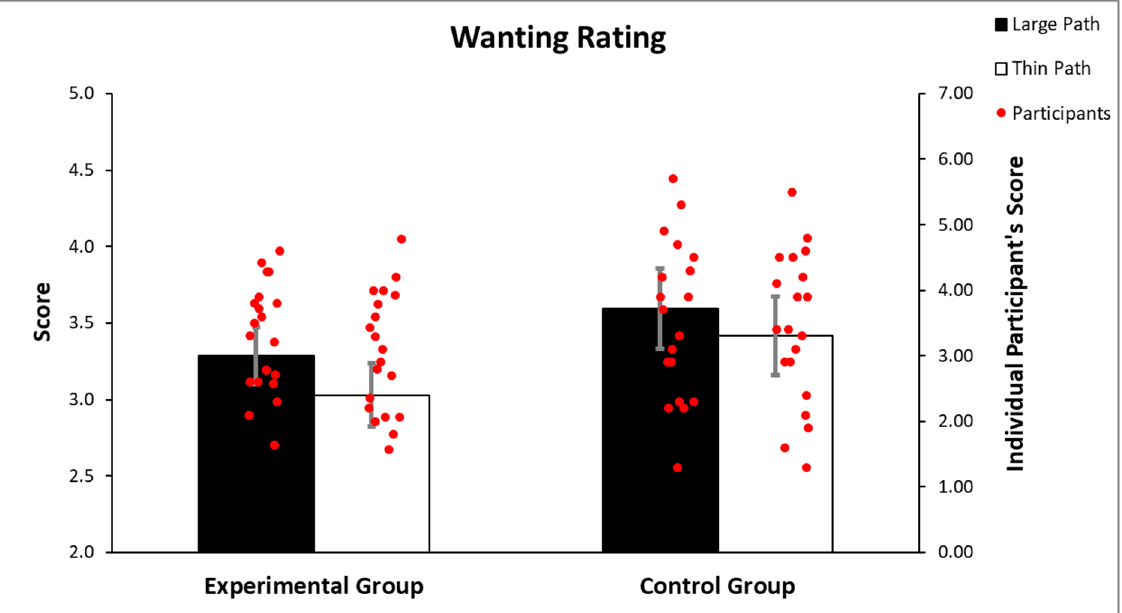
Figure 4. Analysis of the wanting scores illustrates that the wanting ratings were not differently influenced by the path widths in both groups. Vertical lines indicate the standard error of mean (SEM).